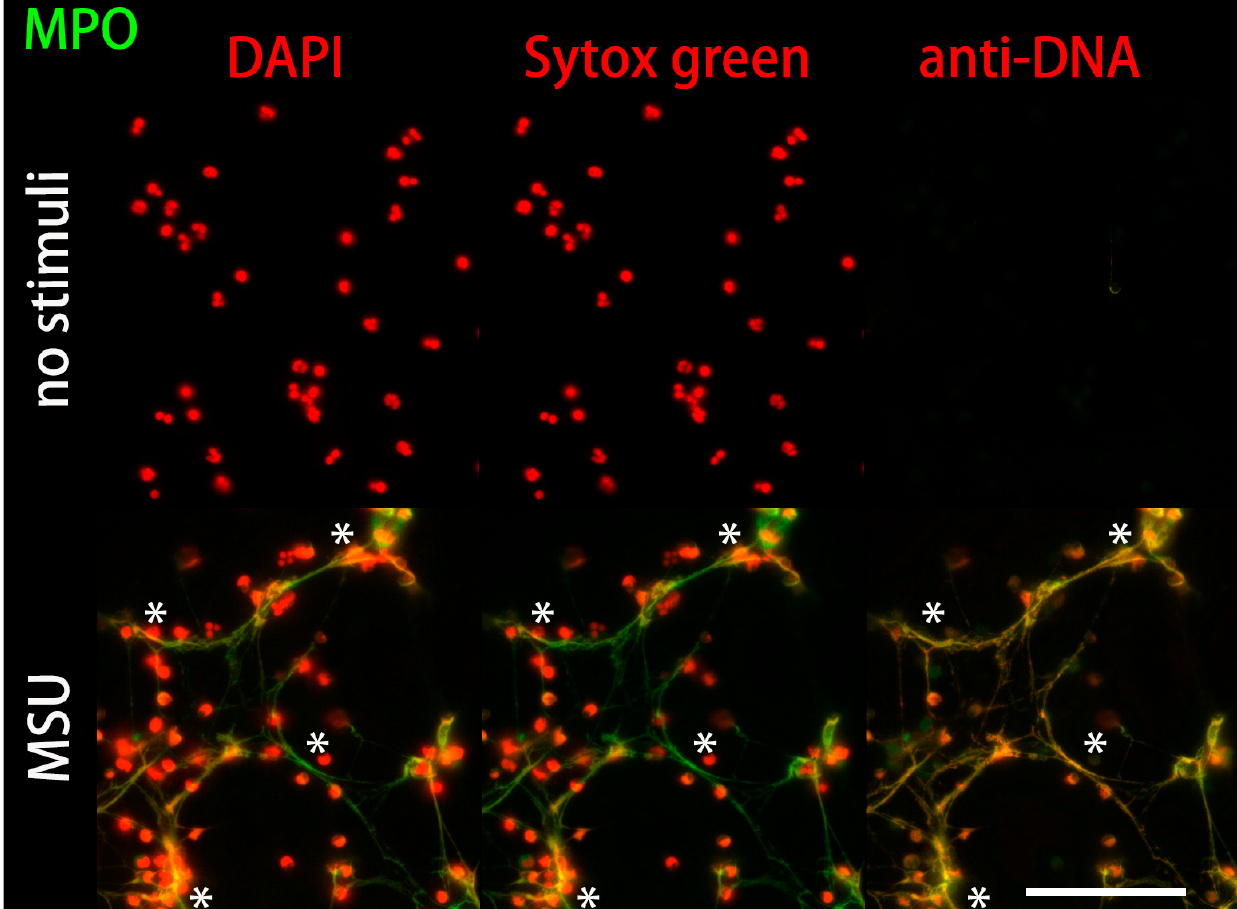
Figure 6. Anti-DNA-IgM stains DNA from NETs with high sensitivity in vitro. Freshly isolated neutrophils from healthy donors were cultured without stimulation (no stimuli), or stimulated with monosodium urate crystals (MSU) to trigger NET formation. Then the samples were stained with the small DNA dyes DAPI (red, first column), SYTOX™ Green (red, second column) or anti-DNA- IgM (red, last column). Fibrous decondensed DNA of NETs was detected robustly by anti-DNA-IgM but virtually not by DAPI and SYTOX™ Green. It co-localized with MPO (asterisk). Unstimulated viable cells show no anti-DNA-IgM signal, but display strong DAPI and SYTOX™ Green signals. Scale bar = 100 µm.